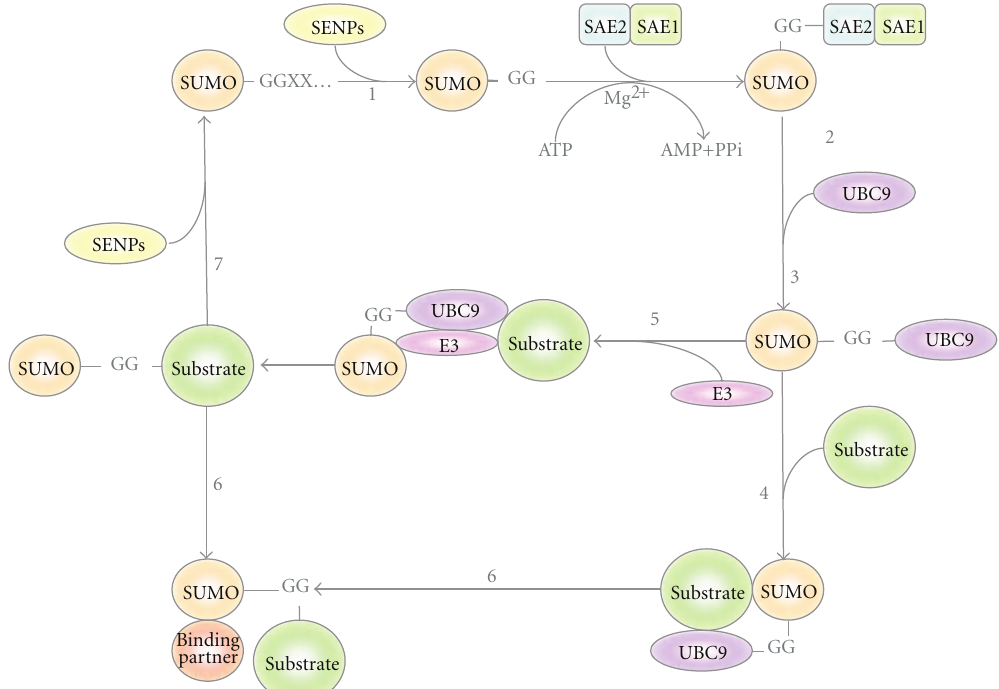
Figure 2: The SUMO conjugation pathway. The immature form of the Small Ubiquitin MOdifier (SUMO) undergoes processing by Ubiquitin-like protein-specific protease (Ulp) and SUMO/Sentrin-specific proteases (/SENPs) to generate its mature form (step 1), revealing a carboxy-terminal Gly-Gly motif. SUMO is then adenylated by the Aos1/Uba2 also named SAE1/SAE2 complex in an ATP · Mg 2+ -dependent reaction (step 2). Following activation, SUMO is transferred to the catalytic Cys of the E2 conjugating enzyme (UBC9) (step 3), which can then catalyze SUMO conjugation to a substrate containing the SUMO consensus motifs ( Ψ K x E) in an E3 ligase-independent (step 4). SUMO E3 ligases can also facilitate SUMO transfer to the substrate proteins (step 5). Substrates modified by SUMO can interact with SUMO-binding proteins through their SUMO-interacting motifs (SIMs) (step 6). SUMO-deconjugation is promoted by Ulp and SUSP/SENP proteases. Free SUMO can be recycled for another round of protein conjugation (step 7). hyperactive SUMO-specific proteases known as SUSPs or SENPs [2, 5] (Figure 2 and Table